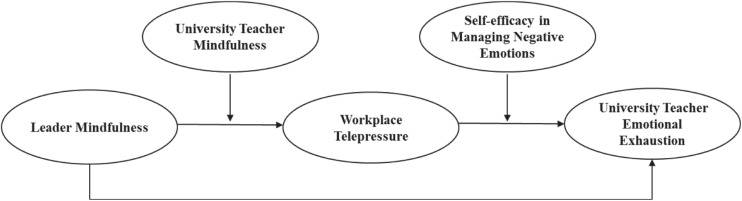
Theoretical model.